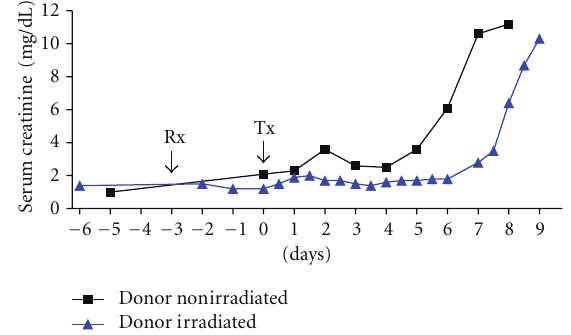
Figure 5: Life-supporting kidney Tx was carried out from (i) a non- irradiated donor (squares) and (ii) an irradiated donor (triangles) into nonsibling recipients without immunosuppressive therapy. The serum creatinine levels of the pigs rose to > 884 μ mol/L ( > 10mg/dL) within 7 and 9 days, respectively. Rx: day of irradiation to donor (day − 3); Tx: day of kidney Tx (day